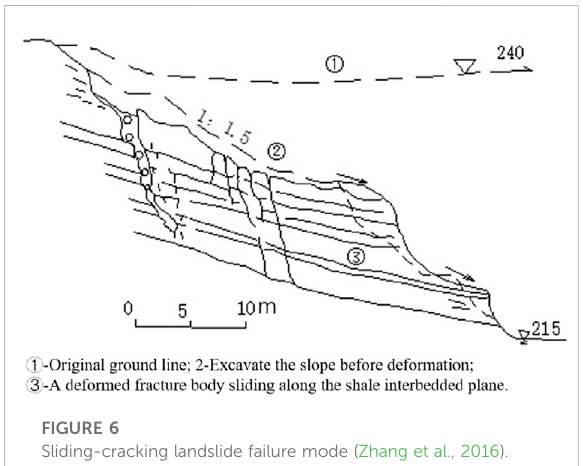
FIGURE 6 Sliding-cracking landslide failure mode (Zhang et al.,